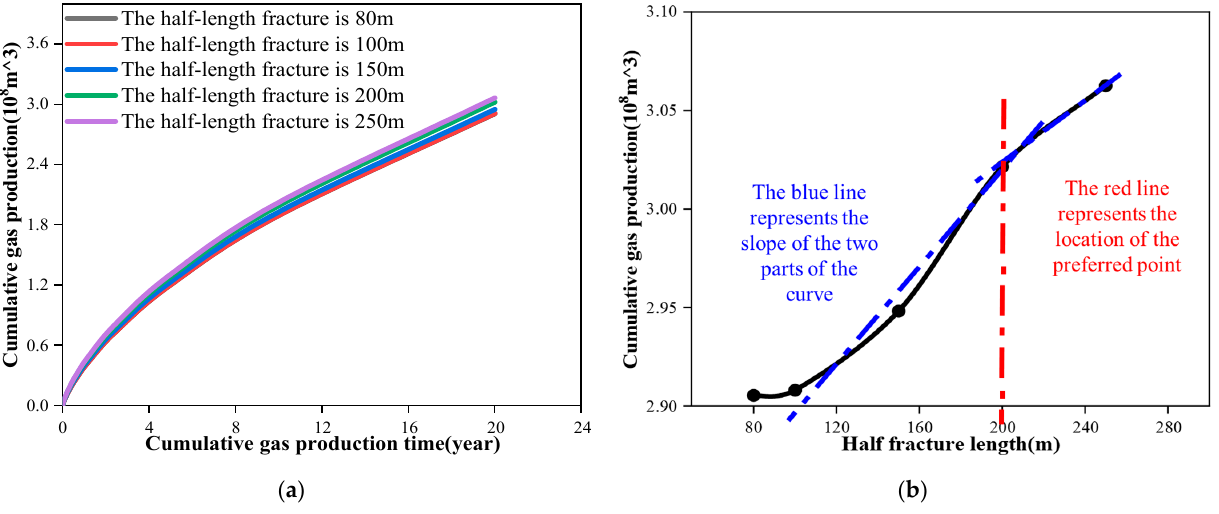
Figure 12. ( a ) Comparison of cumulative production under different half-fracture lengths and ( b ) schematic diagram of optimization of half fracture length.